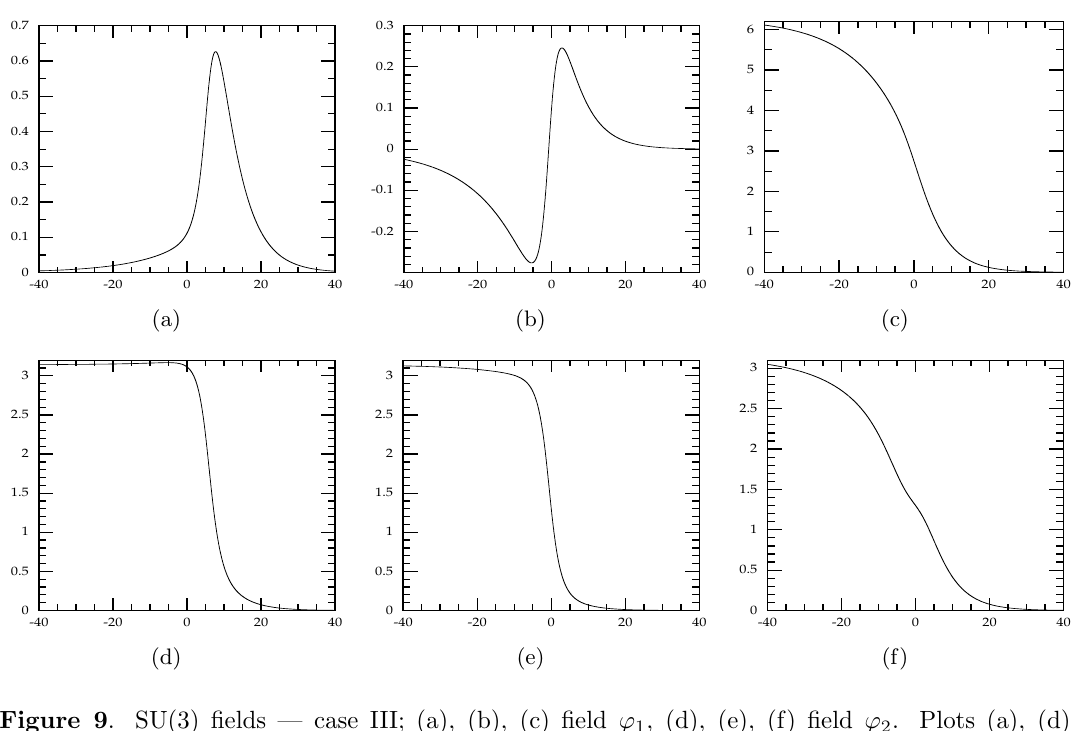
Figure 9 . SU(3) (cid:12)elds | case III; (a), (b), (c) (cid:12)eld ’ 1 , (d), (e), (f) (cid:12)eld ’ 2 . Plots (a), (d) were obtained for the initial conditions ’ 1 (0) = 0 : 1, ’ 2 (0) = 3 : 1095, (b) and (e) for ’ 1 (0) = 0 : 1, ’ 2 (0) = 1 : 3 and (c) and (f) for ’ 1 (0) = 2 : 75, ’ 2 (0) = 1 : 3.